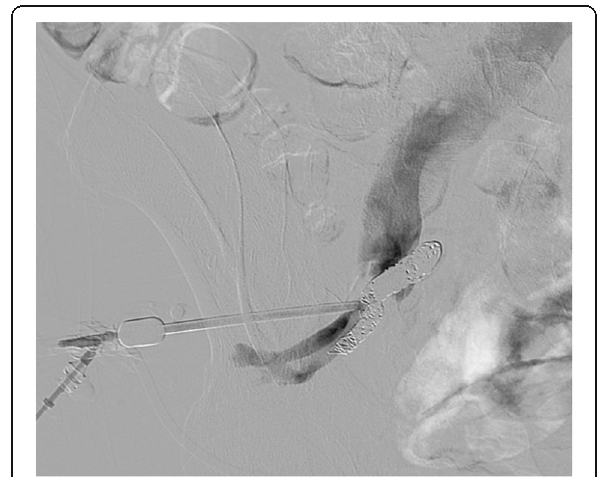
Fig. 2 Direct needle angiogram showed contrast outlining the left iliac vein and lower inferior vena cava, thus confirming concomitant venous